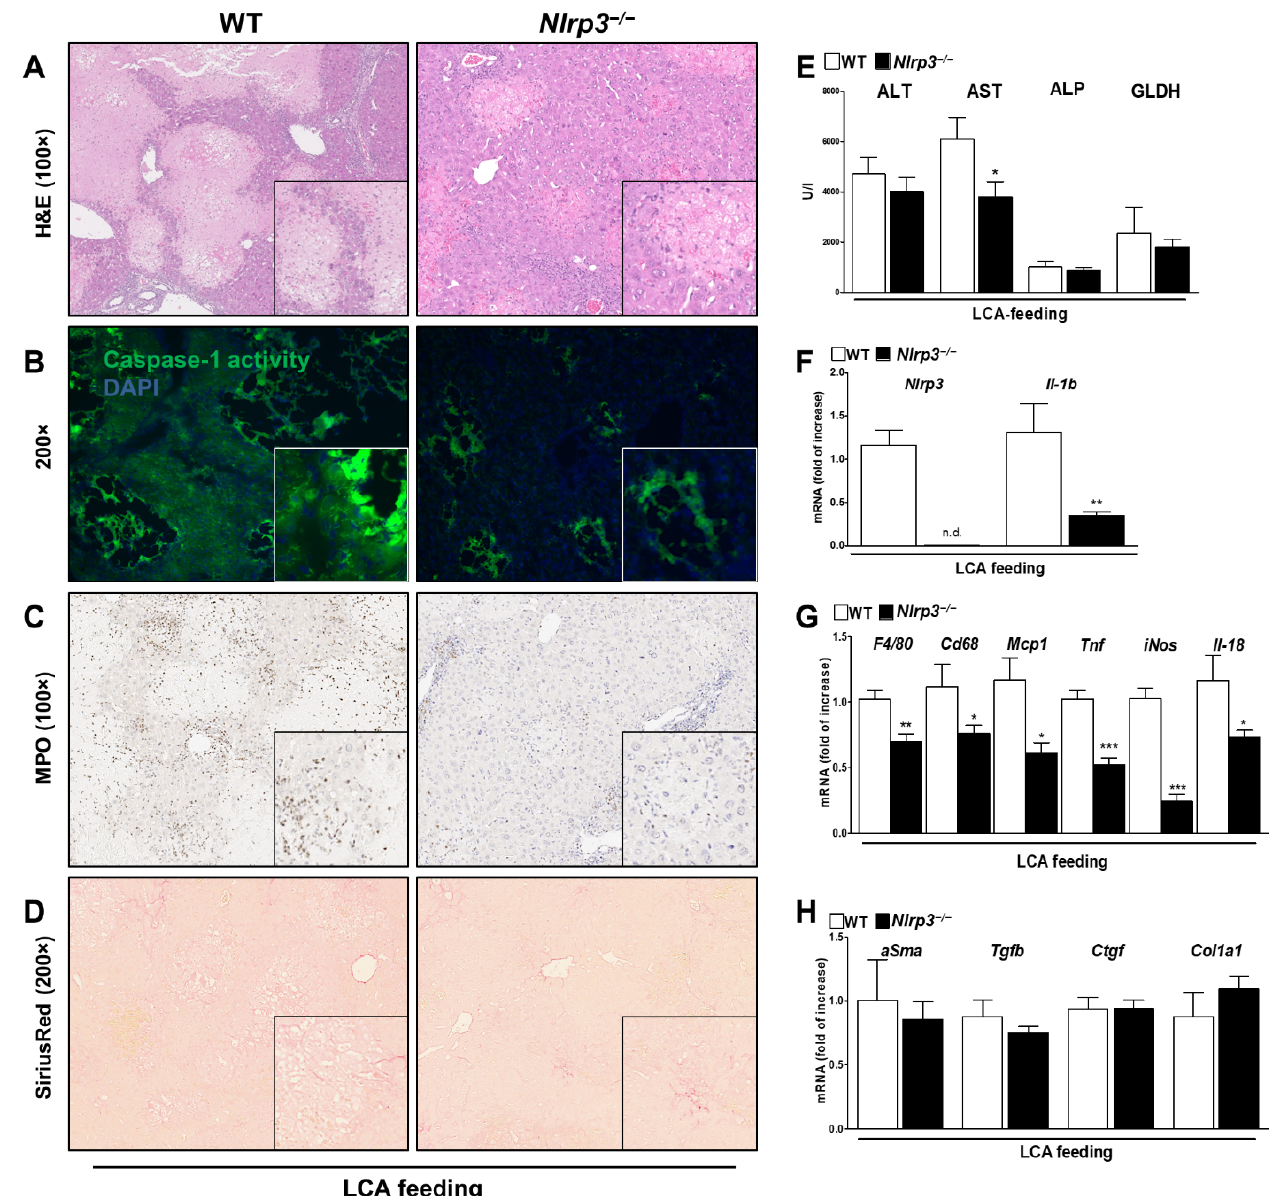
Figure 3. Nlrp3 − / − ameliorated severe liver damage and proinflammatory milieu after LCA feeding. Nlrp3 − / − attenuated severe liver damage after LCA feeding with smaller necrotic areas, fewer bile infarcts and lowered transaminase levels ( A , E ). However, normal morphology was not obtained. Nlrp3 − / − mice revealed lower Caspase-1 activity and Il-1b mRNA levels ( B , F ). Despite NLRP3 deficiency fibrotic markers remained the same ( D , H ), whereas infiltration of inflammatory, MPO-positive cells decreased ( C ). Nlrp3 − / − inhibited a proinflammatory environment after LCA feeding as indicated by decreased mRNA markers of immune cell invasion ( F4/80, Cd68, Mcp1 ) and proinflammatory macrophages ( Tnf, iNos, Il-18 ) ( G ). * p < 0.05; ** p < 0.01; *** p < 0.001; n.d.: not detected; n = 6.